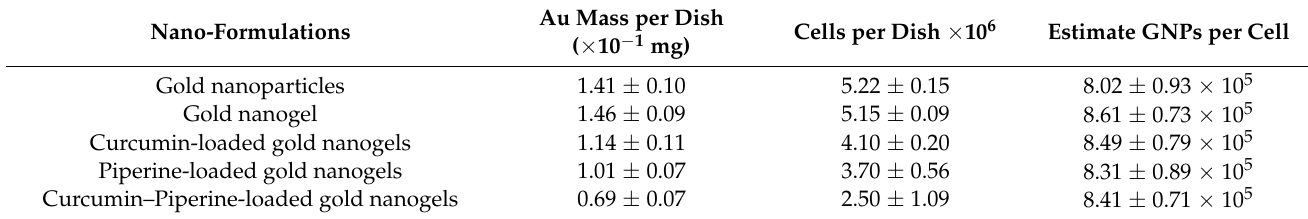
Table 2. Quantification of gold for cell-associated curcumin and piperine gold nanogels (21 µ M) by using atomic absorption spectroscopy analysis on U-251 MG glioblastoma cells after day 3 of treatment ( n = 3).